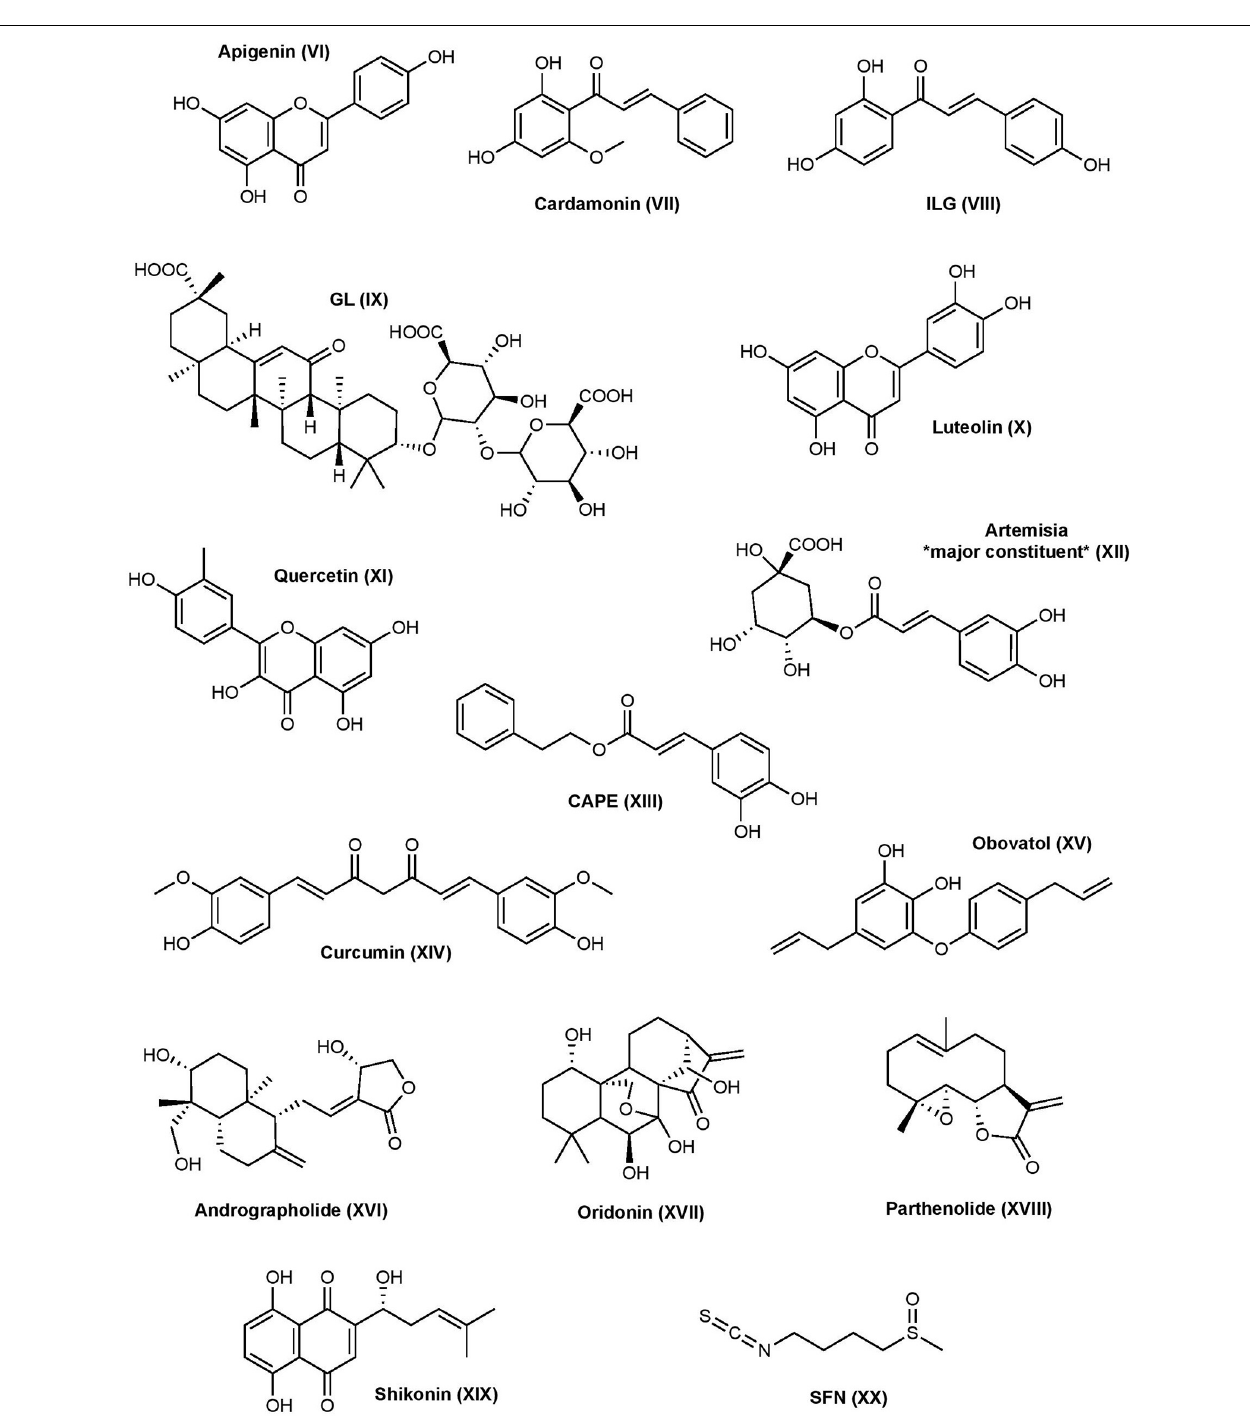
FIGURE 3 | Natural product NLRP3 inhibitors structures.